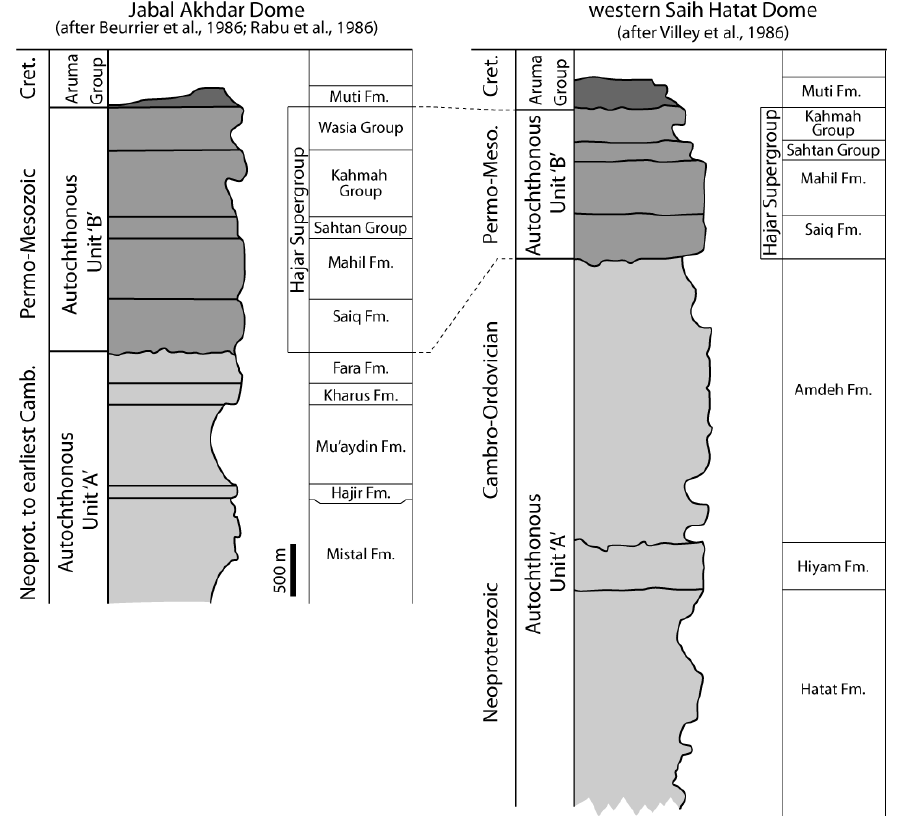
Figure 4. Different stratigraphies of the Jabal Akhdar and Saih Hatat domes, drawn after [13–15]. Note the pronounced differences among the Early Paleozoic formations. The lowermost five formations of the Jabal Akhdar Dome (in light gray) were affected by the Cadomian and Angudan orogenies. The scale applies to both logs.